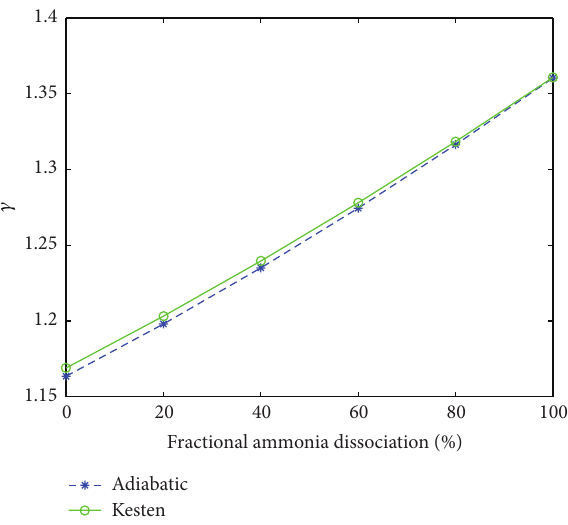
Figure 2: Variation of 𝛾 with NH 3 decomposition percent.